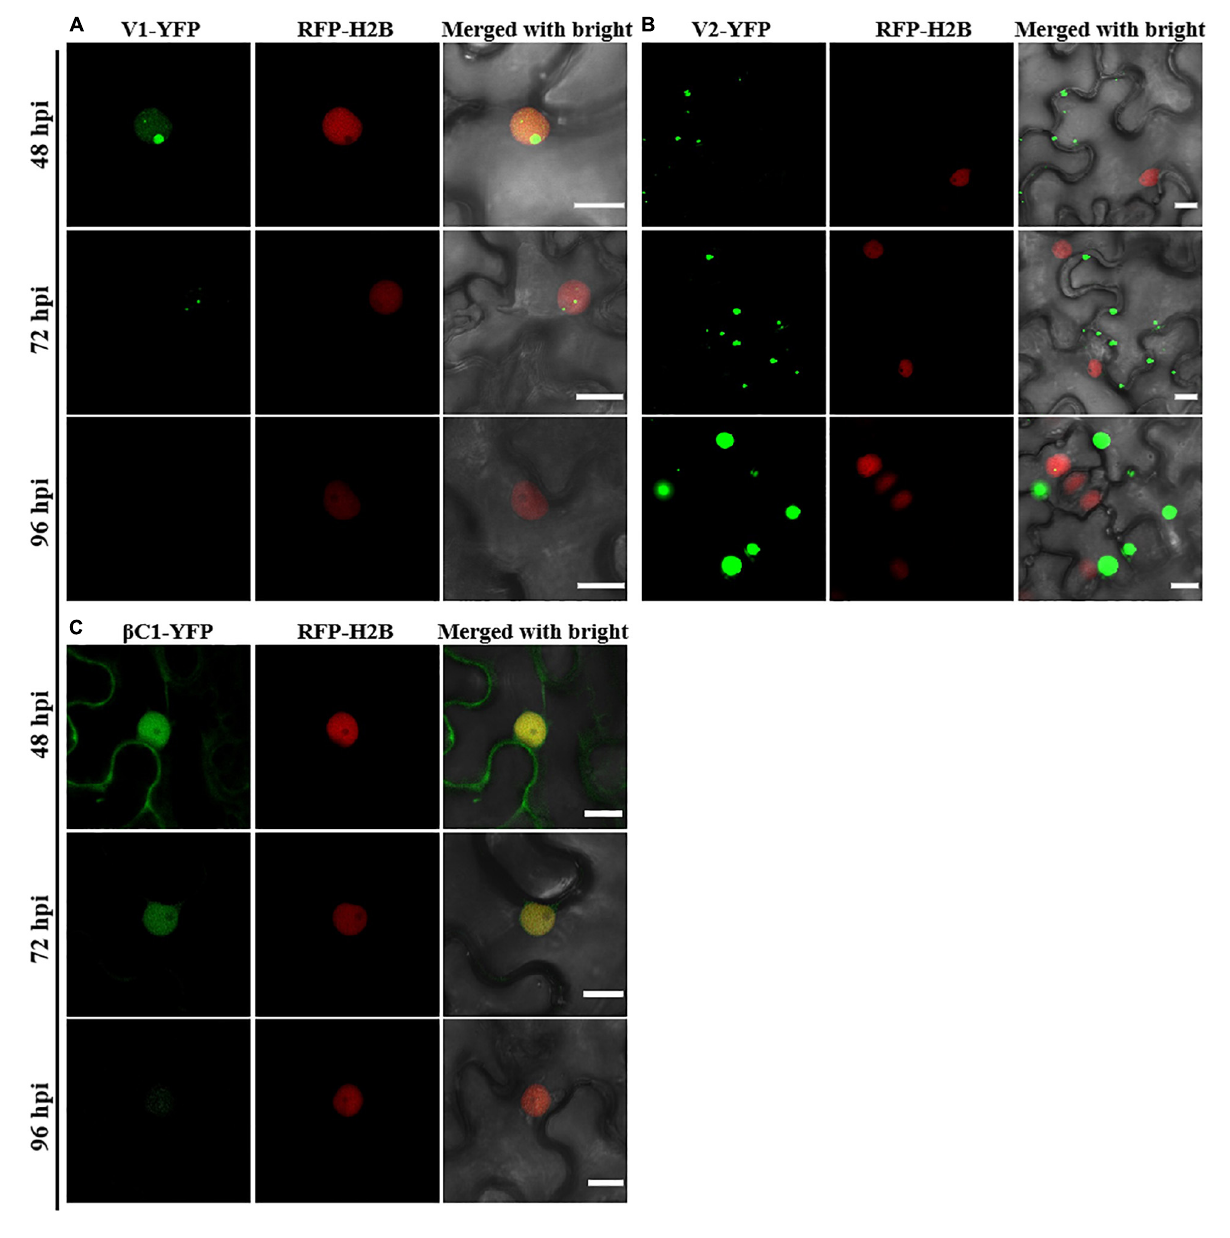
FIGURE 2 | Confocal images of TYLCCNV V1, V2, or TYLCCNB β C1 fused with YFP. RFP-H2B transgenic N. benthamiana leaves were infiltrated with Agrobacterium cultures to express V1-YFP (A) , V2-YFP (B) , or β C1-YFP (C) . Confocal images were taken at 48, 72, and 96 hpi. YFP signal is shown in green. Nuclei of tobacco leaf epidermal cells are marked by RFP-H2B (red). This experiment was repeated three times independently, and more than 20 cells per sample were observed each time; representative results are shown. Scale bar: 10 µ